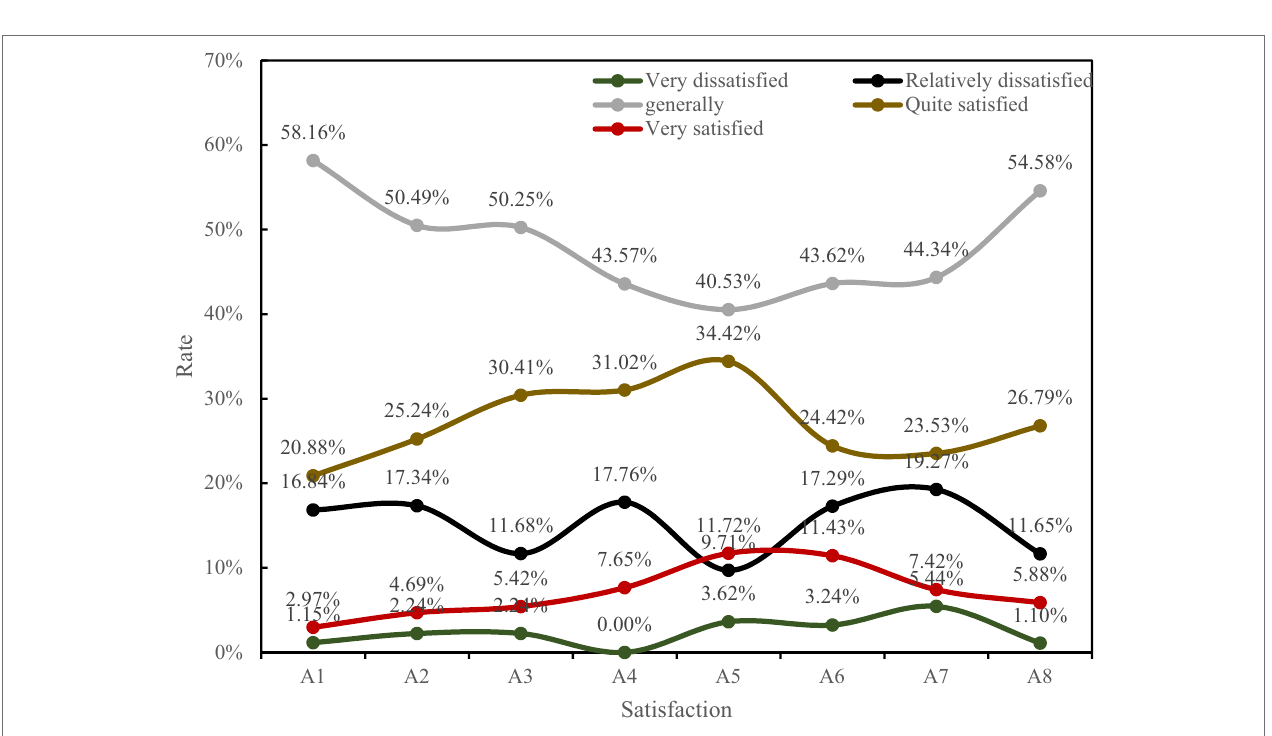
FIGURE 7 | Statistics of student satisfaction in teaching daily psychology